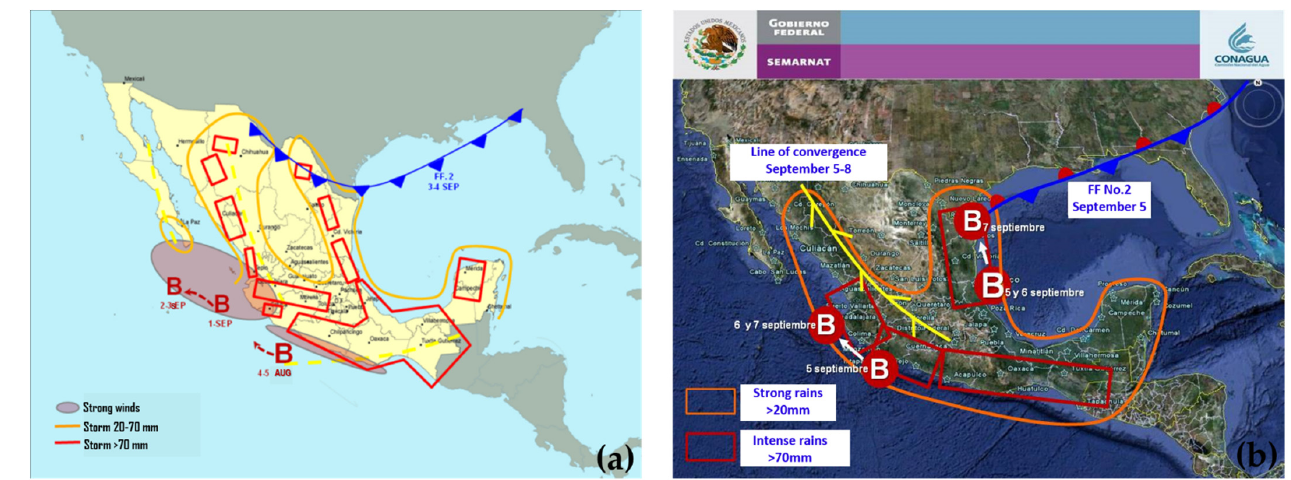
Figure 6. Maps of the weather forecast generated by the Servicio Meteorológico Nacional (SMN) and Comisión Nacional del Agua (CONAGUA) for Mexico from 1 to 8 September 2010. The capital letter B shows the areas of low pressure on the Mexican Pacific coast and in the Gulf of Mexico. The solid and discontinuous yellow lines show the lines of convergence, both in ( a , b ). In ( a ), the line with blue triangles indicates a cold front in northern Mexico, and ( b ) indicates a stationary front. Images were obtained from the Weather Reports provided by the SMN and Conagua.